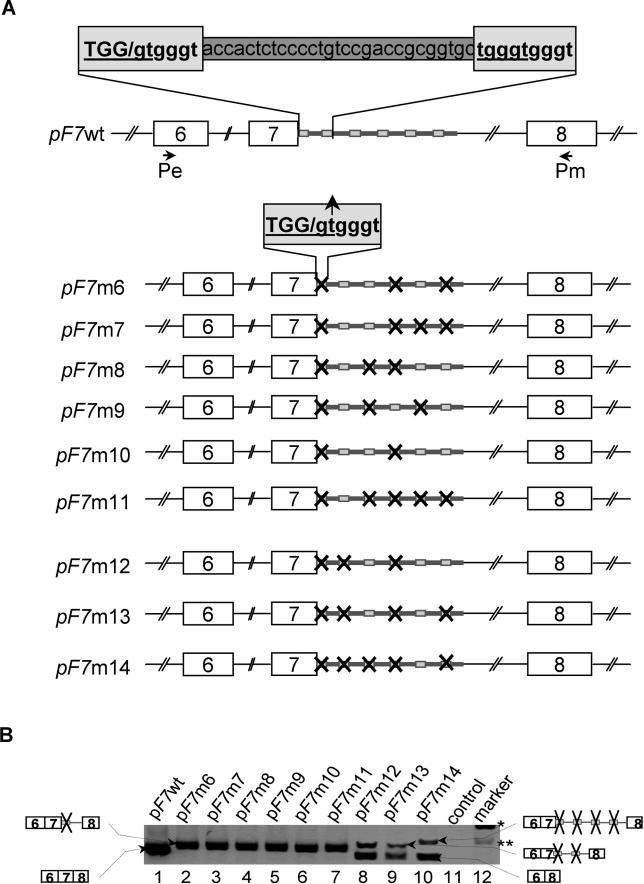
Splice Site Selection in the Context of Functional 5′ Pseudo-Sites, Separated by One or Several Inactivated 5′ Splice Sites(A) Schematic representation of the constructs used in this experiment (see legend to Figure 2A for the meaning of each symbol).(B) RT-PCR amplification of F7 transcripts isolated from CHO cells transfected with the above-mentioned constructs. The products corresponding to the different PCR fragments, as identified by sequencing, are schematically represented on both sides of the figure.